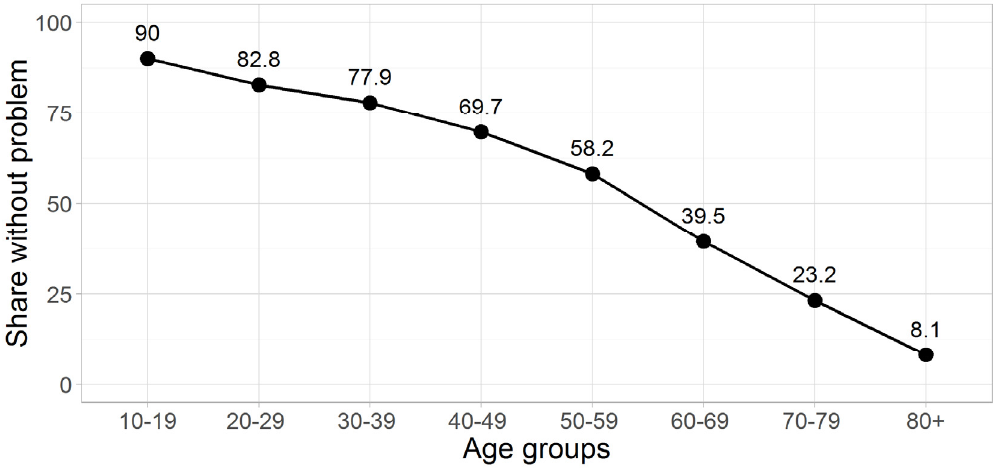
Figure 1. Percentage of respective age group without problem (EQ-5D-5L descriptive score: 11111), aggregated sample.